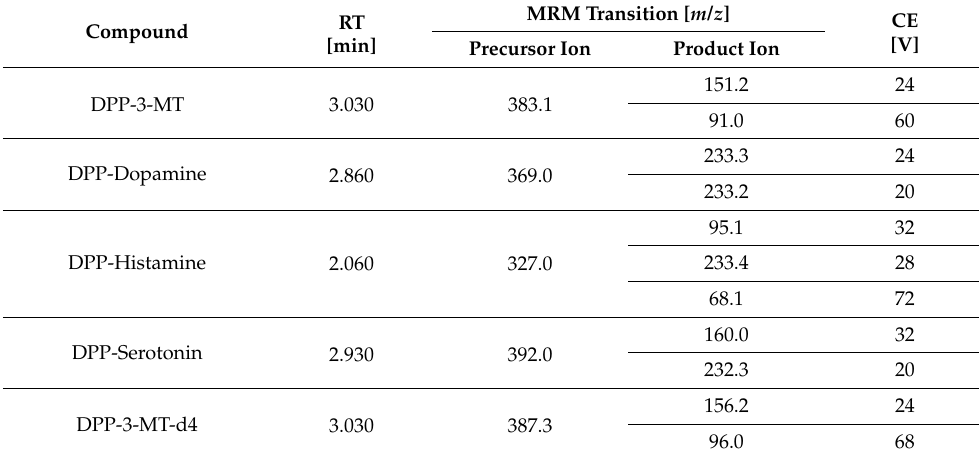
Table 2. MRM parameters for determination of